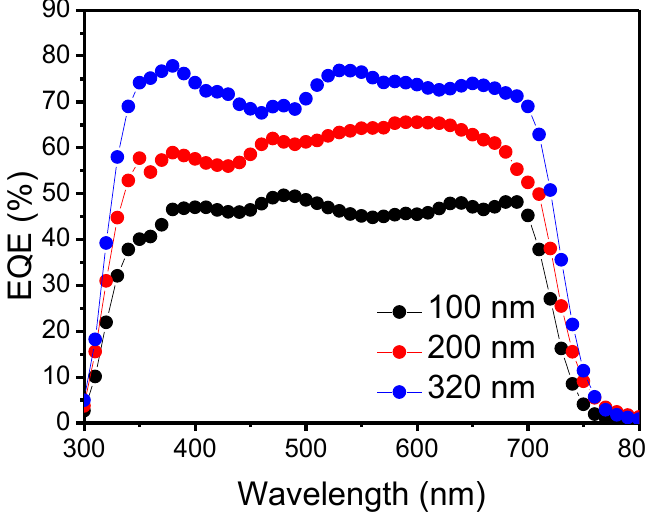
Figure 3. Measured external quantum efficiency (EQE) spectra of SM BHJ OSCs. Table 1. A summary of SM BHJ OSC performances with changes of BHJ thickness. (PCE: Power conversion efficiency.)